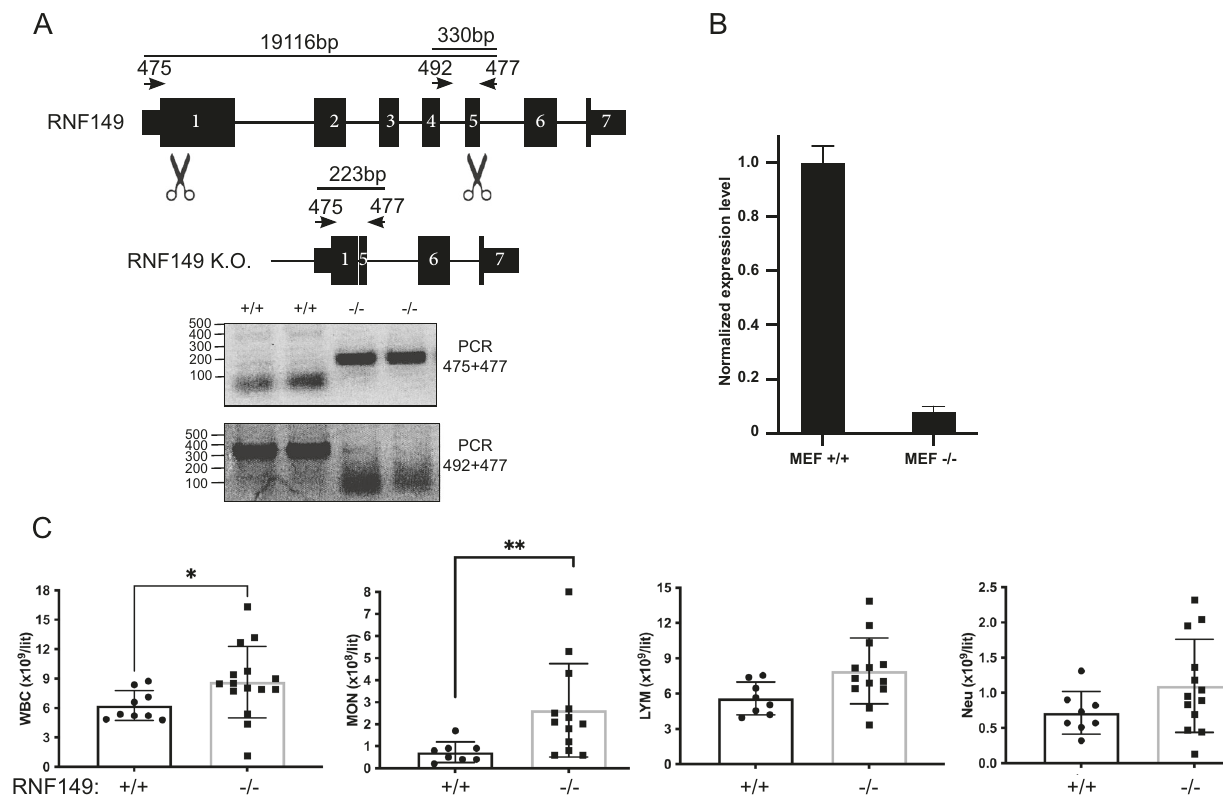
Fig. 3 RNF149 knockout phenotype. A Mouse genomic locus illustration of RNF149 . Forward and reverse primer binding sites (475, 492 and 477) are shown as well as scissor icons indicating the designed Cas9 cleavage sites. Expected PCR product size of the primer sets are indicated. Genotyping examples of RNF149 + / + and RNF149-/- animals using the designated primer sets shown on bottom. PCR products were sequenced and con fi rmed the deletion of the 19 kb RNF149 genomic fragment. B RT-PCR results of cDNA samples from the indicated genotypes were performed on MEF cells from the respective mice. RNA levels were normalized to a housekeeping gene (HPRT1). C Blood cells extracted from the indicated RNF149 genotype were evaluated at the age of 6 month. WBC-white blood cells; Neu-neutrophils; Mon-monocyte; Lym-lymphocyte. * p < 0.05; ** p <